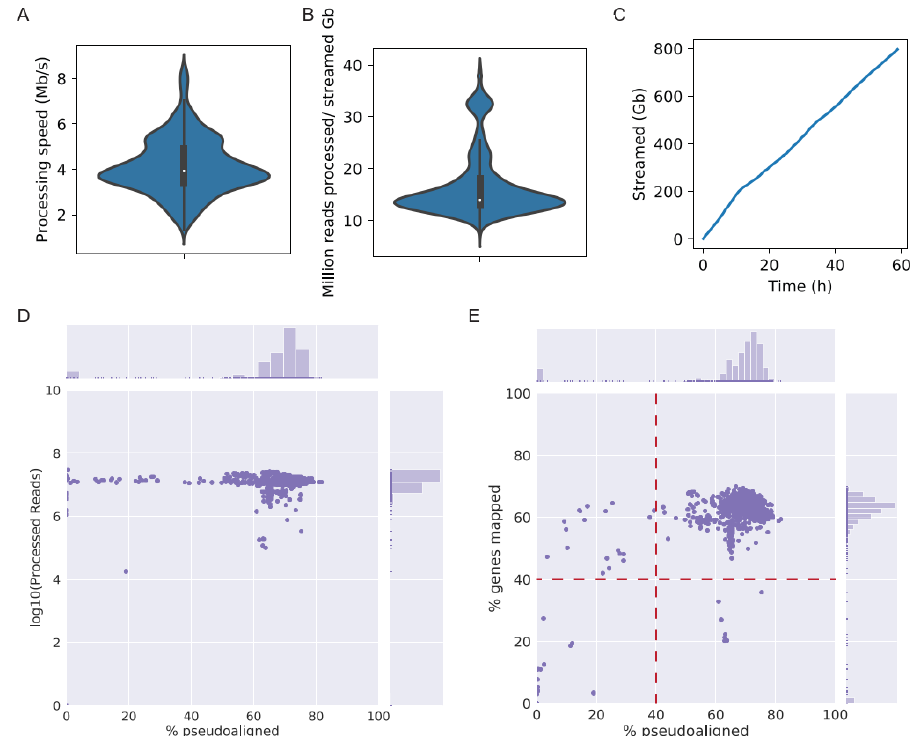
Figure 2. Summary of tobacco experiments streamed and processed by LSTrAP-Cloud. ( A ) The violin plot shows the speed of simultaneous streaming and processing of RNA-seq files by kallisto. ( B ) Amount of reads processed per gigabyte streamed. ( C ) Cumulative size ( y -axis) of files streamed over time ( x -axis). ( D ) The scatterplot shows the percentage of reads pseudoaligned to the coding sequences (CDS) ( x -axis) against the total number of streamed reads ( y -axis) for each experiment, which are represented as dots on the plot. ( E ) The percentage of reads pseudoaligned to the CDS ( x -axis) versus the percentage of genes with nonzero Transcripts Per Kilobase Million (TPM) values ( y -axis) for each experiment, which are represented as dots on the plot. Red lines indicate cutoffs that were used to the select experiments for downstream analyses.